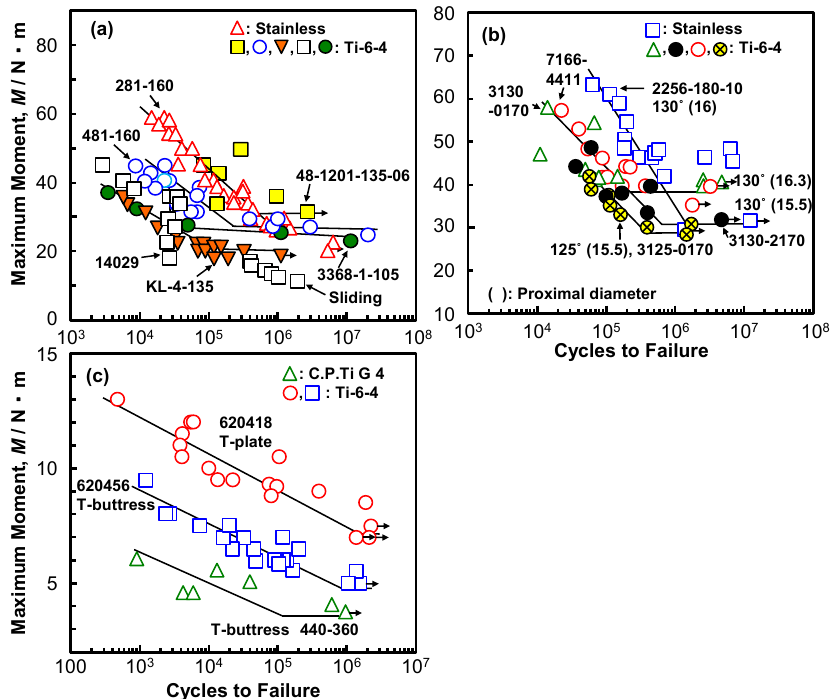
Figure 7. M–N curves of ( a ) CHSs, ( b ) short femoral nails, and ( c ) epiphyseal plates that were obtained by compression bending durability tests.